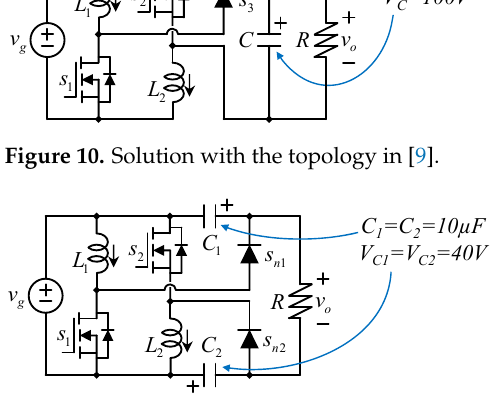
Figure 11. Solution with the proposed topology.